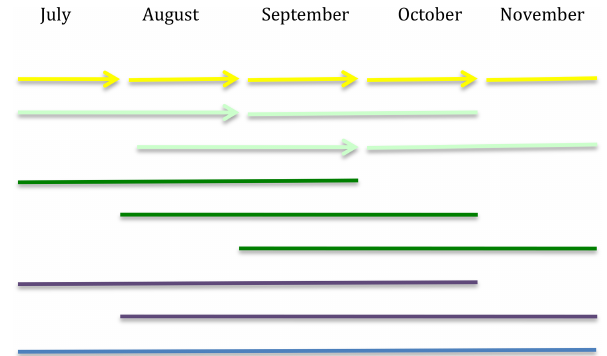
Figure 1. Overview of the incubation design. Different color bars represent the incubation time periods: yellow corresponds to 30d, light green to 60d, dark green to 90d, purple to 120d and blue to 150d of incubation. The arrows represent the points in time when the same holes from the previous incubation were used to incubate the next set of mesh